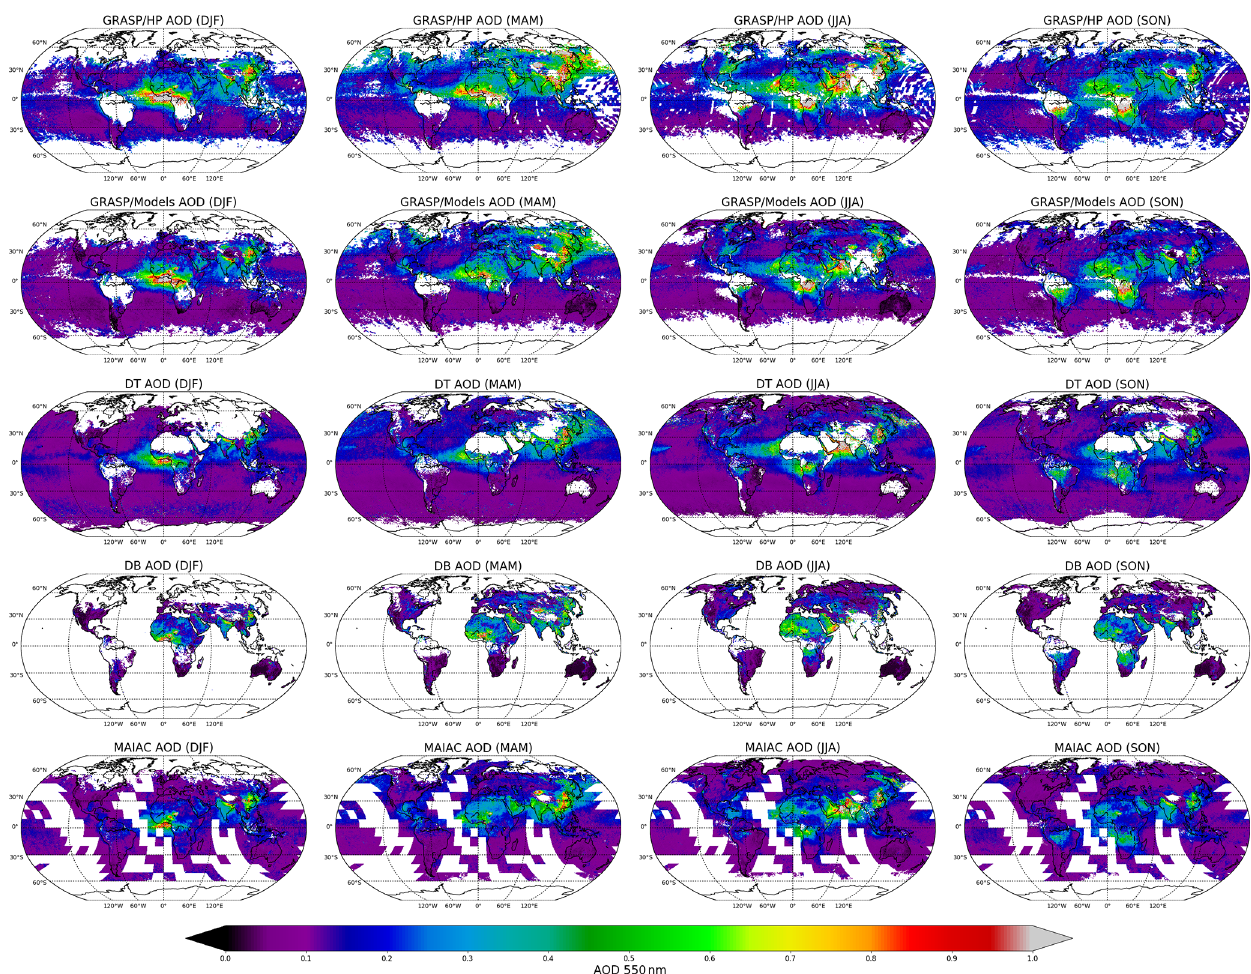
Figure 21. Spatial distribution of 0.1 ◦ × 0.1 ◦ seasonal AOD (550nm) from PARASOL (GRASP/HP and GRASP/Models) and MODIS (DT, DB and MAIAC) products. DJF: December–January–February; MAM: March–April–May; JJA: June–July–August; SON: September–